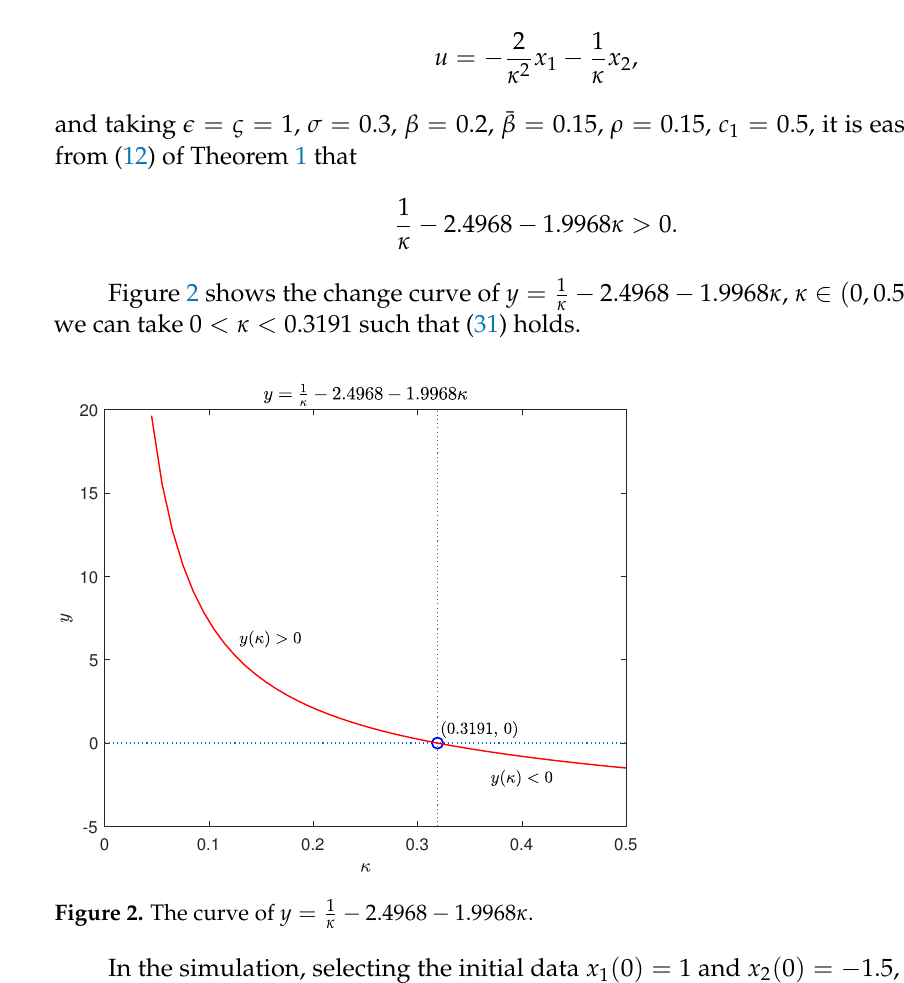
− 2.4968 − 1.9968 κ . Figure 2. The curve of y = 1 κ In the simulation, selecting the initial data x 1 ( 0 ) = 1 and x 2 ( 0 ) = − 1.5, Figures 3–5, respectively, provide the responses of the closed-loop system (29) and (30) with different parameter values κ = 0.1, 0.2, 0.3.